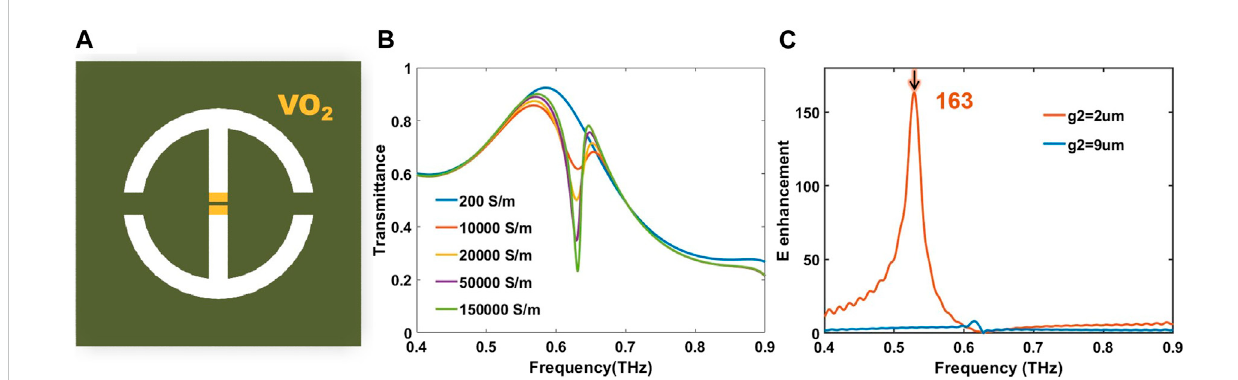
FIGURE 5 (A) Schematic diagram of the VO 2 − Al metasurface. The metal design dimensions are as follows: period p = 100 µm, the ring outer diameter D = 120 µm, width W = 10 µm, both side seam width g 1 = 10 µm, g 2 = 8 µm. After vanadium oxide fi lling, the intermediate seam width changes to 2 µm. (B) The amplitude transmission spectrum of the metasurfaces at the corresponding conductivity to different temperatures. High-temperature state, the amplitude transmission spectrum of the metasurfaces of different g 2 . (C) Simulated fi eld enhancement of the metasurface center. Electric fi eld enhancementto quasi-BIC responses distant from theBIC point (red)andclose to theBIC point (blue).Field enhancementaway from theBIC point (red) can reach